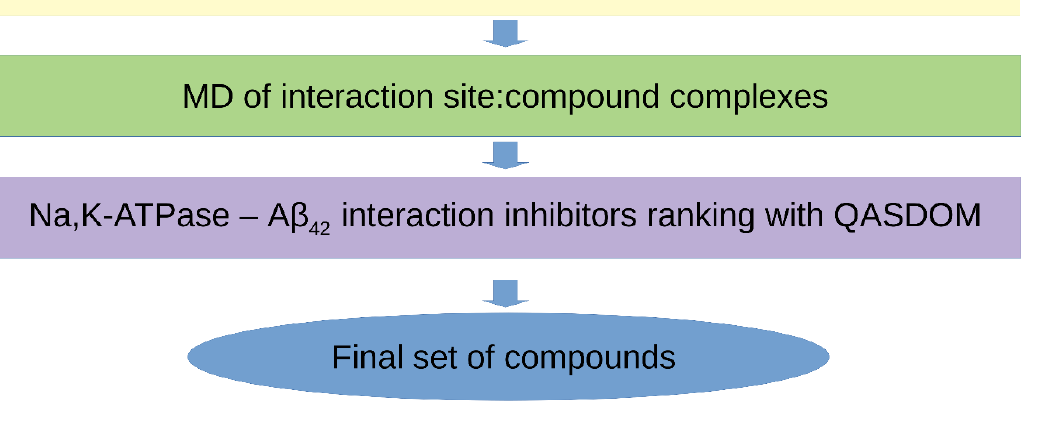
Figure 1. The workflow scheme for the inhibitor search for the A β 42 –Na,K-ATPase interaction by computer modeling.